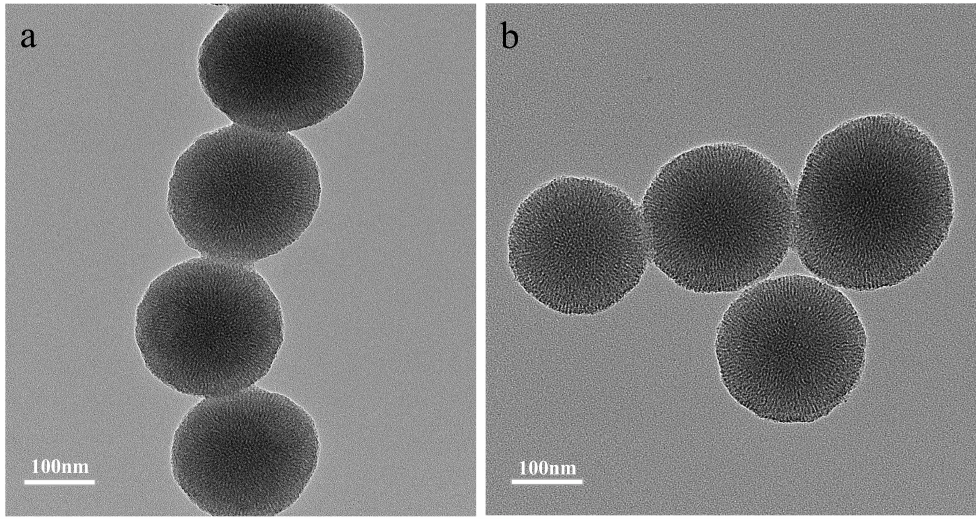
Figure 2. Transmission electron microscope (TEM) images of MIMs ( a ) and NIMs ( b ).